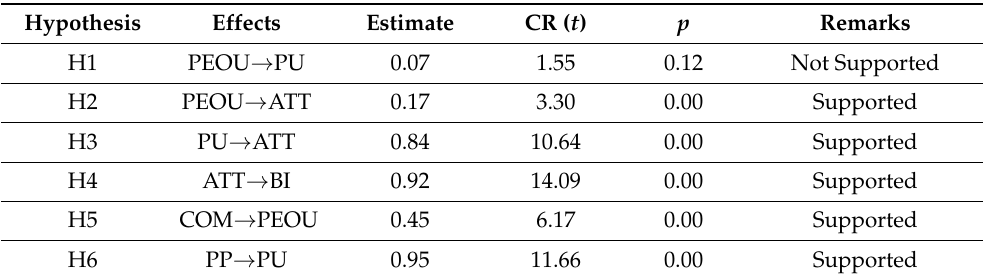
Figure 3. Hypothesis Testing Results of the Structural Equation Model. Abbreviation: COM= Com- patibility; PP= Perceived Playfulness; PEOU= Perceived Ease of Use; PU= Perceived Usefulness; ATT= Attitude; BI= Behavioral Intention; e1–e26 are measurement errors; COM1-3 are survey questions for COM; PP1-4 are survey questions for PP; PEOU1-4 are survey questions for PEOU; PU1-4 are survey questions for PU; ATT1-4 are survey questions for ATT; BI1-3 are survey questions for BI. Table 3. Results of hypothesis tests.